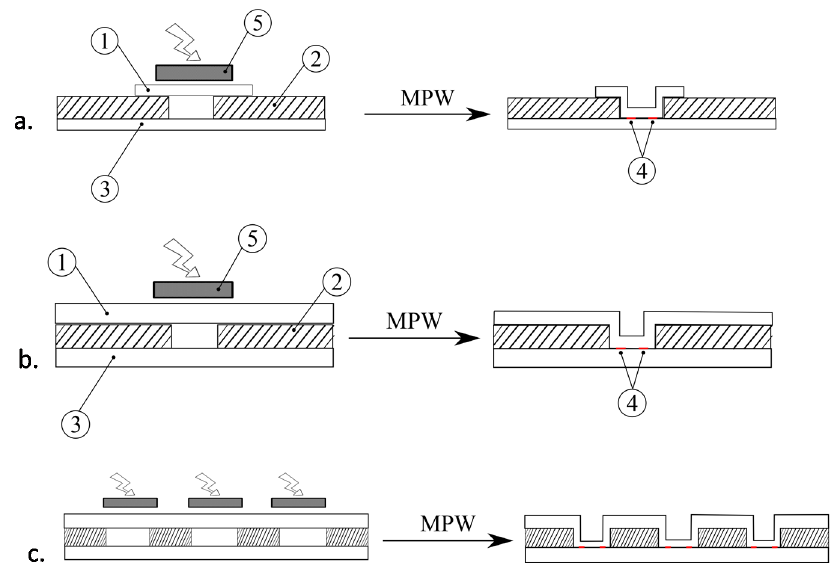
Figure 3. ( a ) Configuration 2 with small patch–(1) Metallic patch; (2) FRPC; (3) metallic sheet; (4) welding area; (5) coil, ( b , c ) composite embedded between two sheets assembled via MPW [52].